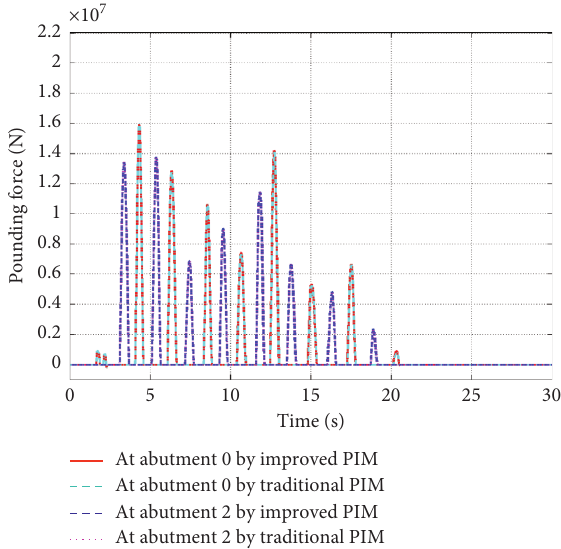
Figure 6: Pounding force time-history curve under rare earth- quake excitation.